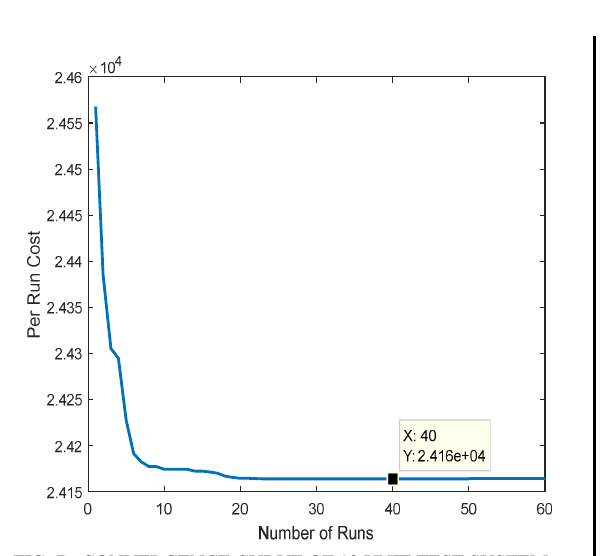
FIG. 7: CONVERGENCE CURVE OF 13 UNIT TEST SYSTEM (